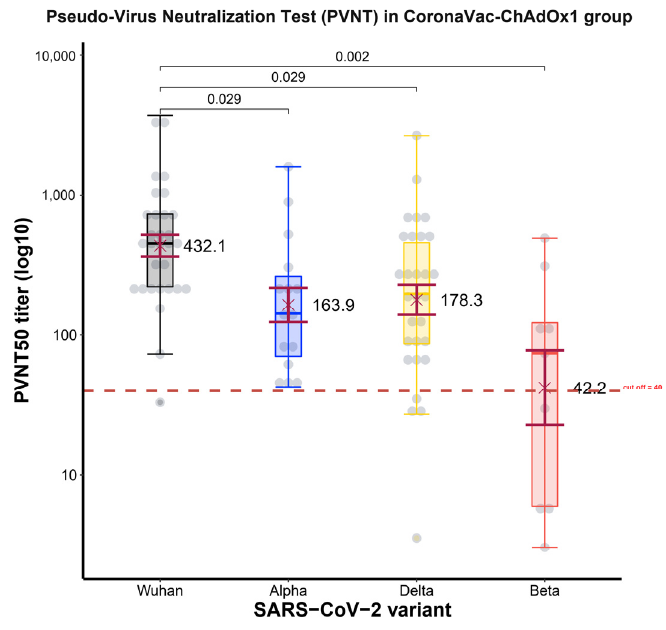
Figure 6. Boxplots of PVNT 50 level in CoronaVac-ChAdOx1 group. Boxplots indicate geometric mean PVNT 50 titer to virus variant and IQRs. Serum collection was performed 2 weeks after participants in the CoronaVac-ChAdOx1 group received the vaccination. The GMT of PVNT 50 was highest against the wild-type (432.1 BAU/mL, 95% CI 299–624), being significantly greater than against the Delta (178.3 BAU/mL, 95% CI 107–298) ( p = 0.029), Alpha (163.9 BAU/mL, 95% CI 89–301) ( p = 0.029), and Beta variants (42.2 BAU/mL, 95% CI 10–173) ( p = 0.002). The horizontal dotted line indicates the positive detection (40 units). The Wilcoxon signed-rank test was used for